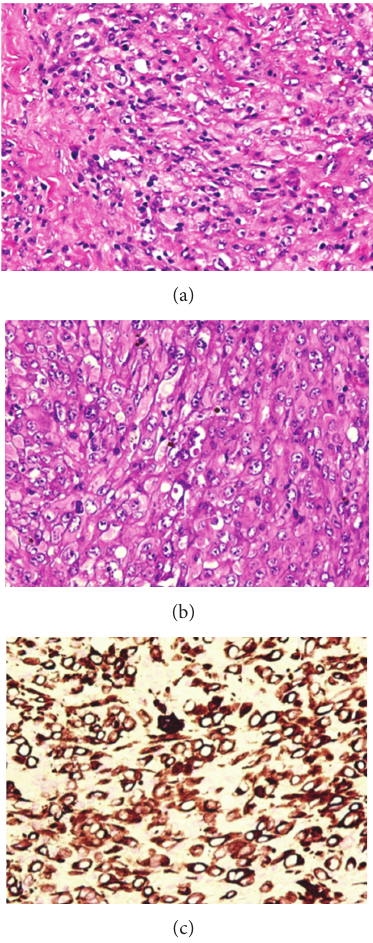
Figure 2: Histopathological features of this sarcomatoid urothe- lial carcinoma. (a) Sarcomatoid changes with areas of necro- sis/hemorrhage (H&E, 200x). (b) More carcinomatoid features of the tumor cells (H&E, 200x). (c) Cytokeratin immunohistochem- istry shows strong positivity of the tumor cells (200x), indicating carcinoma origin instead of true